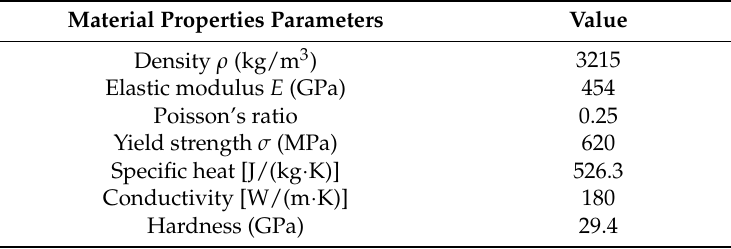
Table 2. The physical parameters of silicon carbide (SiC)